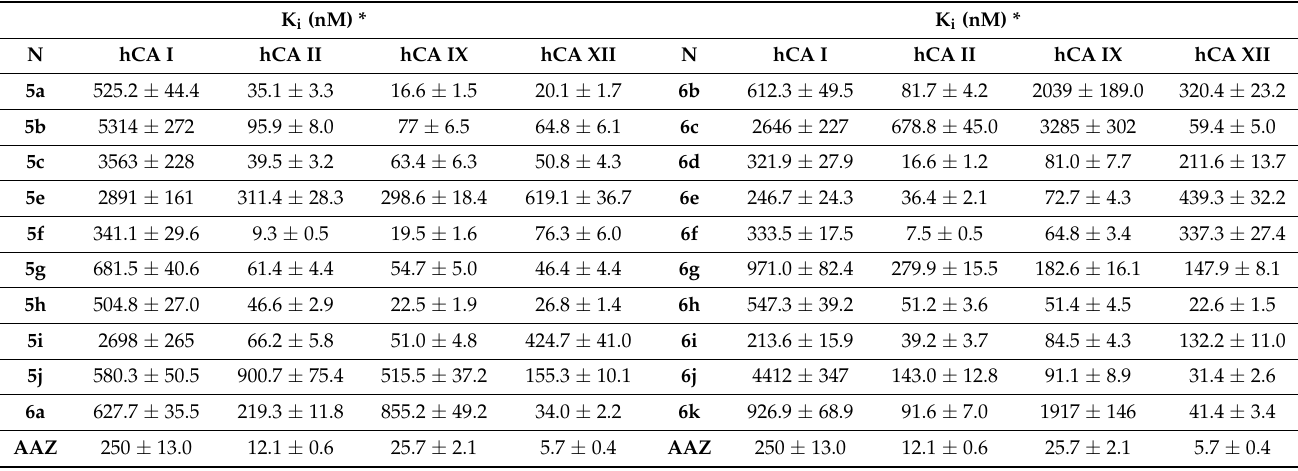
Table 1. Inhibition data of human CA isoforms hCA I, II, IX, and XII with compounds 1–14 and the standard sulfonamide inhibitor acetazolamide